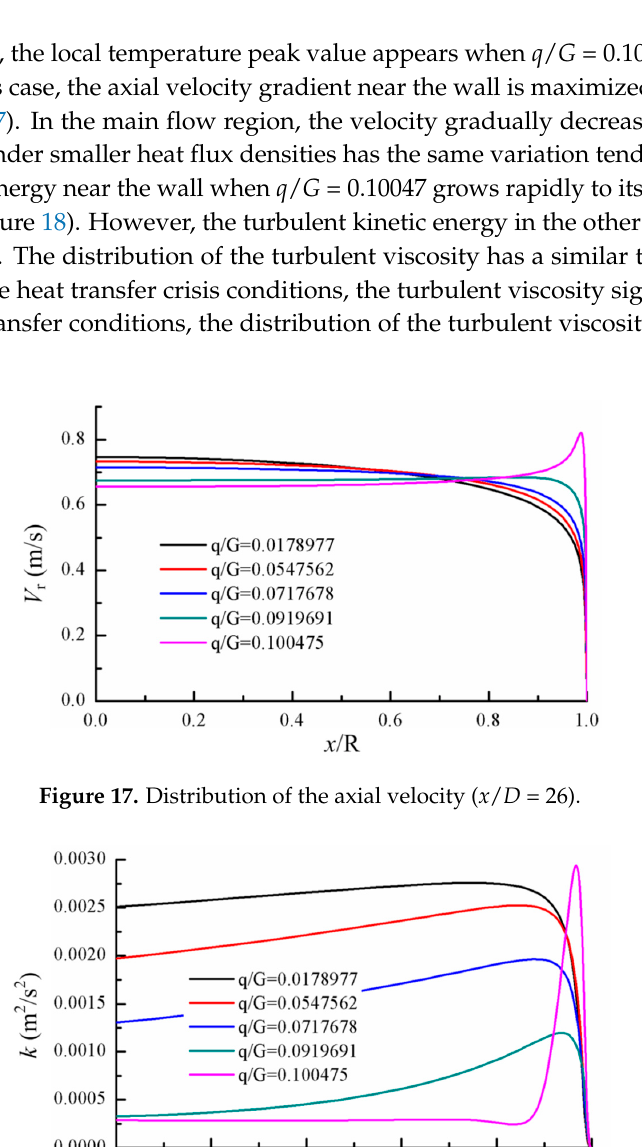
Figure 16. Distribution of the turbulent viscosity ( x/D = 13.2).